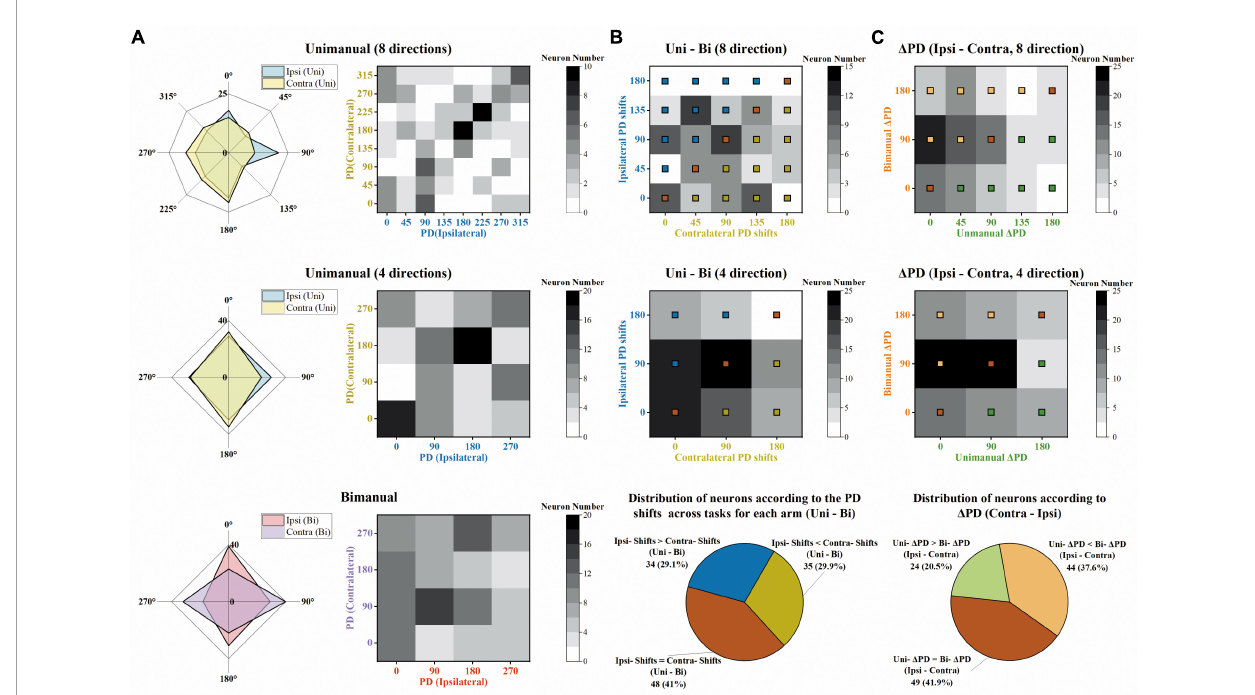
FIGURE8 The same degree of preferred direction (PD) shifts for ipsilateral and contralateral sides across unimanual and bimanual tasks. (A) Top row Distribution of PDs for the ipsilateral (blue) and contralateral (yellow) arm movements, for the unimanual-8-direction data. Middle row and bottom row Same as in the top row, but for the unimanual-4-direction data (middle row) and the bimanual data (bottom row). (B) Top row and middle row Distribution of the PD shifts for ipsilateral (y-axis) and contralateral (x-axis) arms across unimanual versus bimanual tasks, for 8-direction (top row) and 4-direction data (middle row). Bottom row Classification of neurons according to the degree of ipsilateral and contralateral PD shifts across tasks, for 4-direction data in the middle row. While the bronze squares represent the neurons with the same ipsilateral and contralateral PD shifts across unimanual and bimanual tasks, blue squares and yellow squares represent those with larger ipsilateral PD shifts and larger contralateral PD shifts, respectively. (C) Top row and middle row Distribution of (cid:49) PD during unimanual (x-axis) versus bimanual (y-axis) movements, for 8-direction (top row) and 4-direction data (middle row). Bottom row Classification of neurons according to the degree of (cid:49) PD during the two tasks, for 4-direction data in the middle row. Similar to panel (B) , the neurons with the same (cid:49) PD in the unimanual and bimanual tasks are marked with bronze squares, and other neurons with larger (cid:49) PD in unimanual or in bimanual tasks are marked with green and orange squares, respectively. The above results show that the ipsilateral and contralateral sides exhibited the same degree of PD shifts across unimanual and bimanual tasks and these shifts contributed to the larger (cid:49) PD in the bimanual versus unimanual